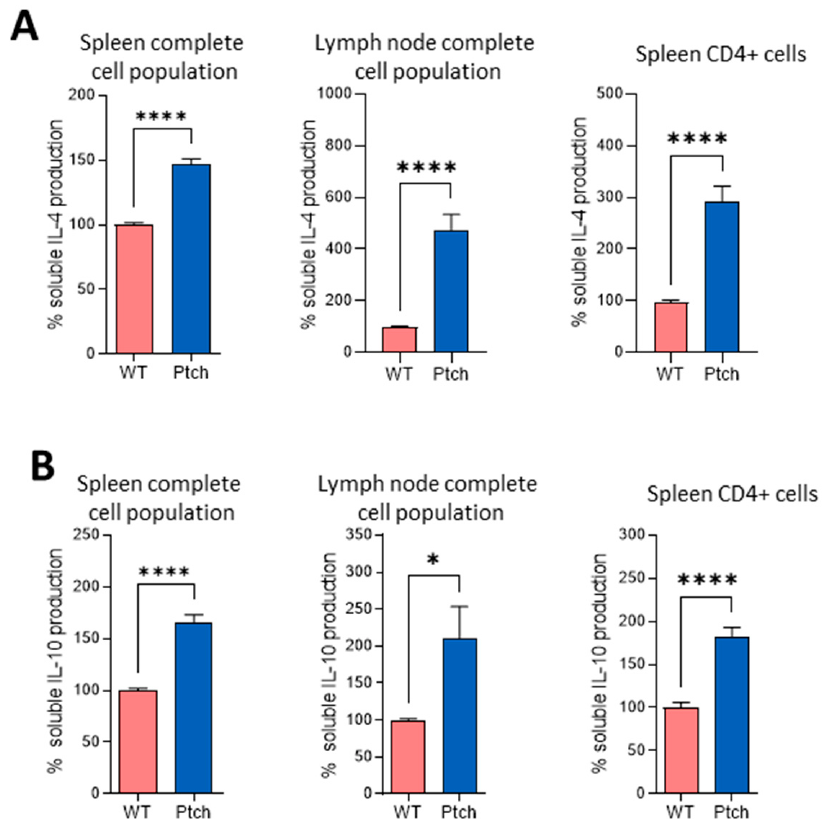
Figure 1. Th2 cytokines produced by T lymphocytes from ptch +/ − and wt mice. Total-cell populations from spleen or lymph node (LN) or purified spleen CD4 + cells from ptch +/ − and wt mice were stimulated in vitro by using α CD3/ α CD28. Three-day culture supernatants were subjected to ELISA analysis for IL-4 ( A ) and IL-10 ( B ) determinations. The results are represented as percentages of the values found for wt mice. Data are the mean of six independent experiments in which each sample was assayed in quadruplicate. Each sample corresponds to a pool of spleen or LN cells from four mice. Standard errors of the means are shown. Statistical significance is indicated as * p < 0.05 and **** p < 0.0001.